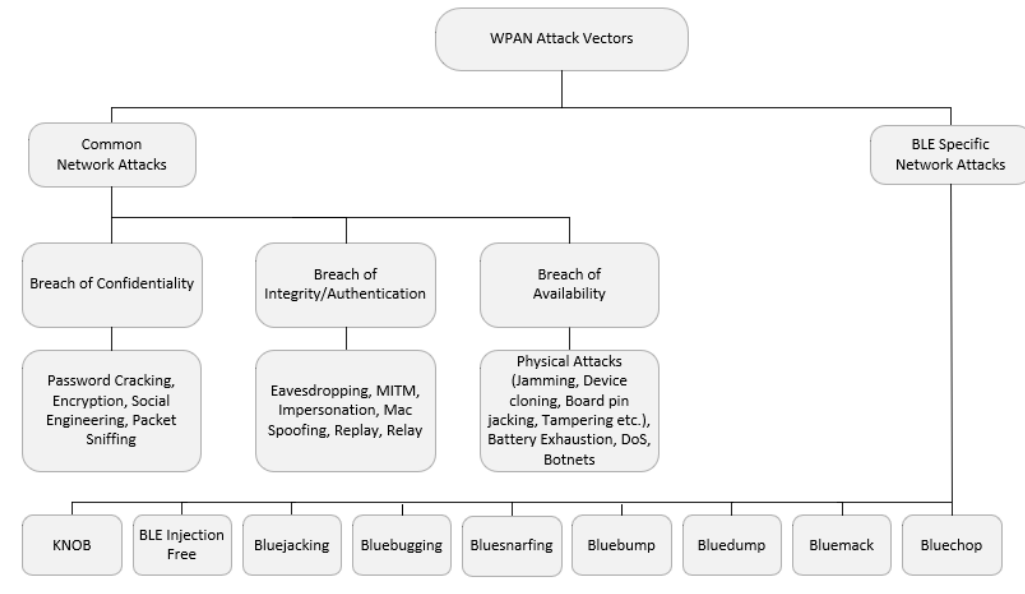
Figure 6. Wireless Personal Area Network (WPAN) Attack